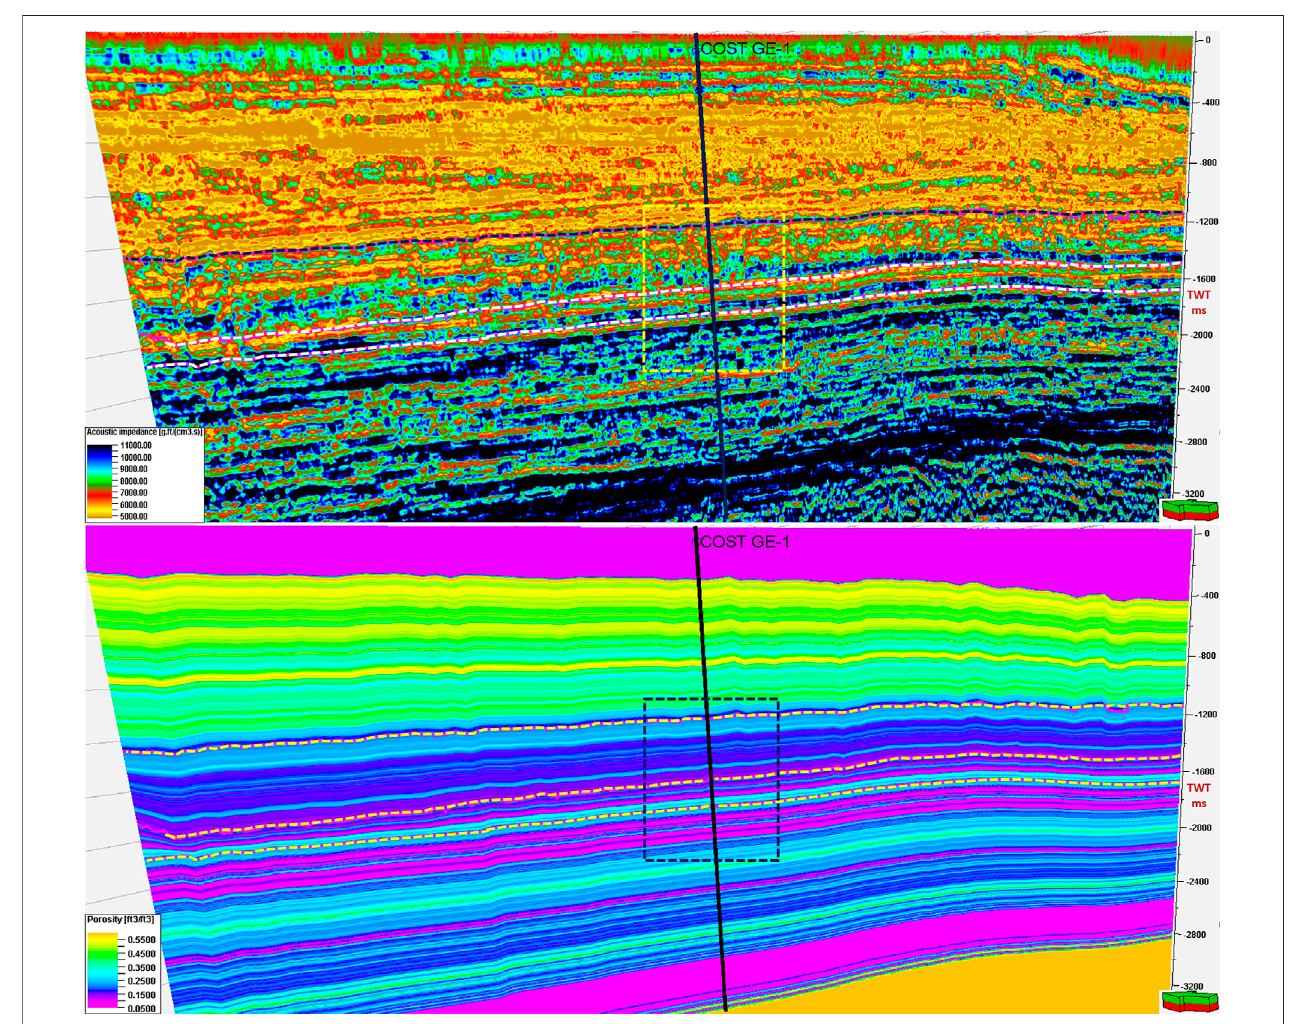
FIGURE 9 | 3D view of the acoustic impedance (top) and the extrapolated porosity (bottom), using seismic lines # 7053A across the COST GE-1 well.